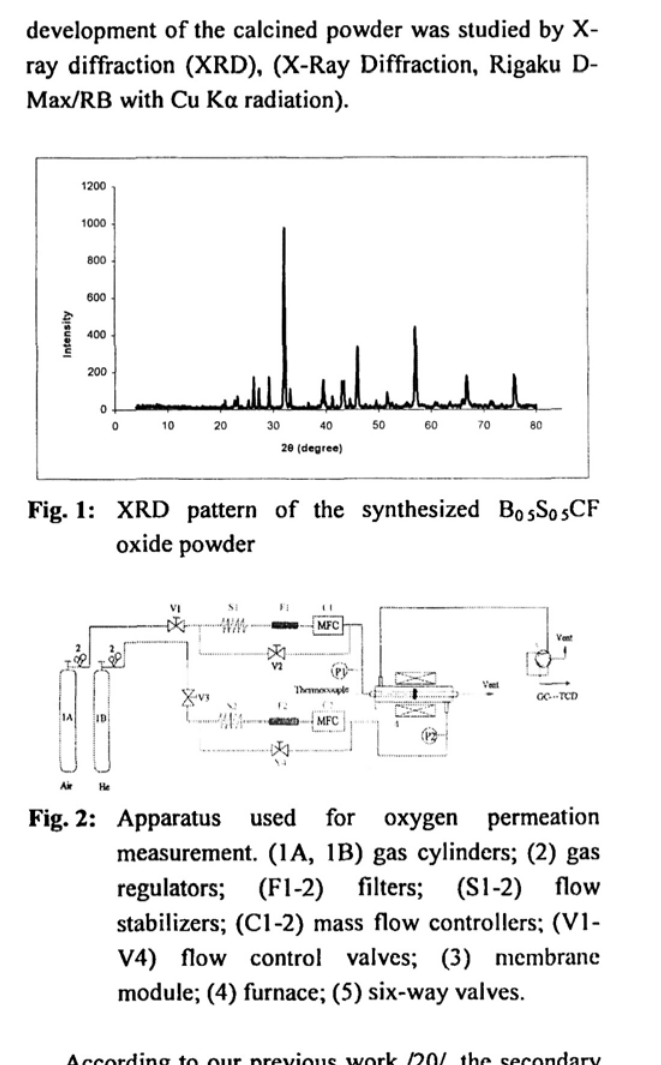
Fig. 2: Apparatus used for oxygen permeation measurement. (1A, IB) gas cylinders; (2) gas